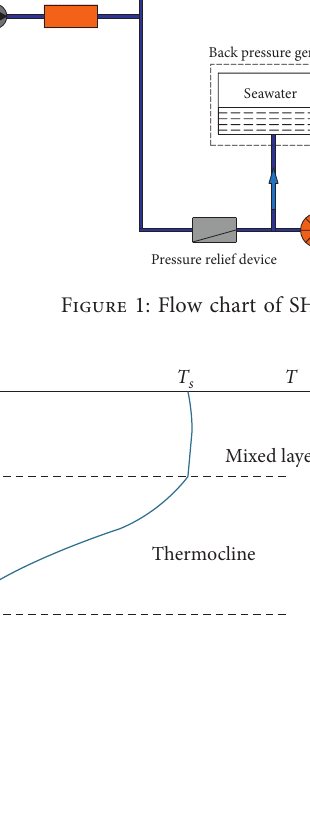
Figure 2: Vertical profile of ocean temperature.